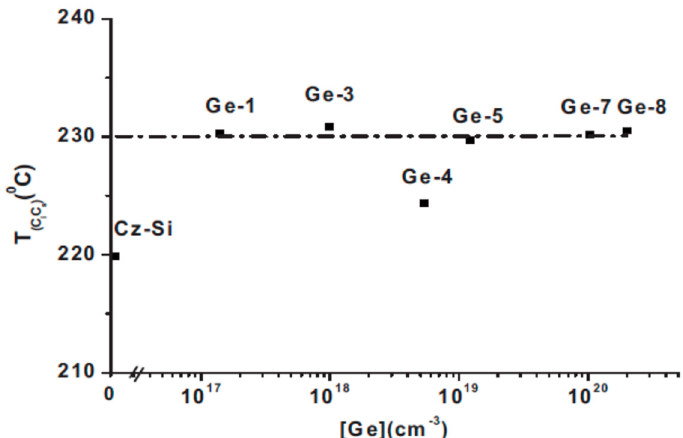
Figure 26. The annealing temperature T ann of the C i C s defect as a function of the Ge concentration Reproduced with permission from [128]. American Institute of Physics, 2010.